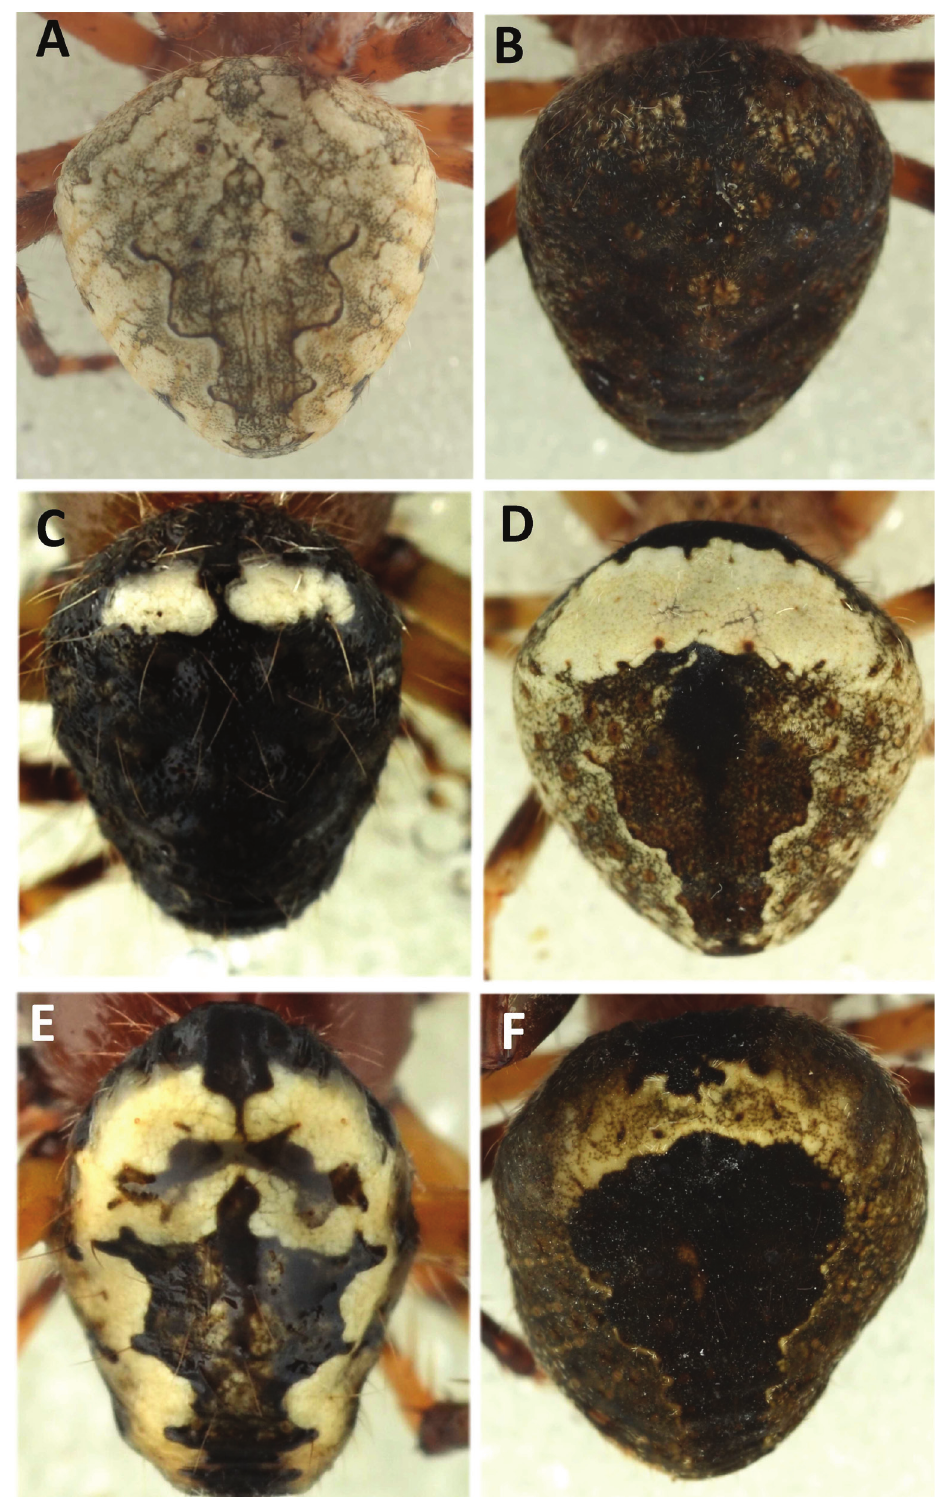
Fig. 2. Eustala occidentalis sp. nov., examples of abdominal patterns. A . ♀ from Isla Rábida. B . ♀ from Isla Santa Cruz. C . ♂ from Isla Isabela, Tagus Cove. D . ♀ from Isla Pinta. E . ♂ from Isla Santa Cruz. F . ♀ from Isla Santiago. Scale lines = 1 mm. Photographs: Alain